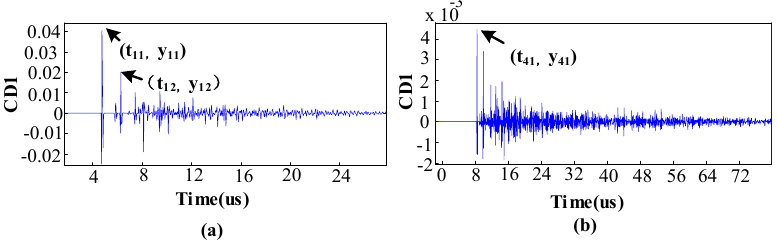
Figure 11. The coefficient of the first level (CD1) component of aerial-mode voltage of Figure 10. ( a ) The CD1 at measurement unit1; ( b ) The CD1 at measurement unit 4.